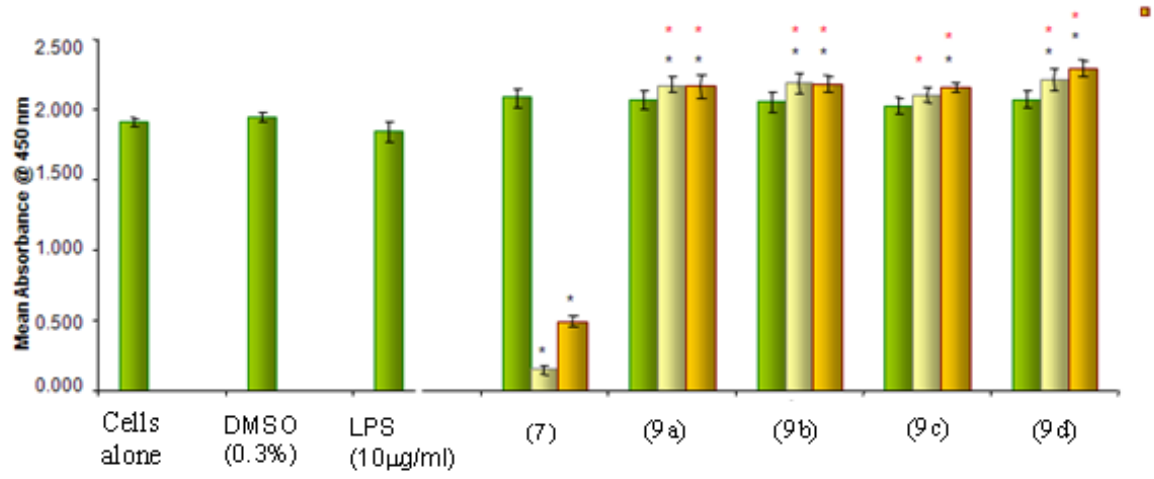
Figure 3. The effects of curcumin ( 7 ) and nitric oxide donating curcuminoids 9a – d on the viability of THP-1 cells as determined by the MTS assay. Results are presented as mean ± SD. * p < 0.05 compared with DMSO control, * p > 0.05 compared with curcumin control ( 7